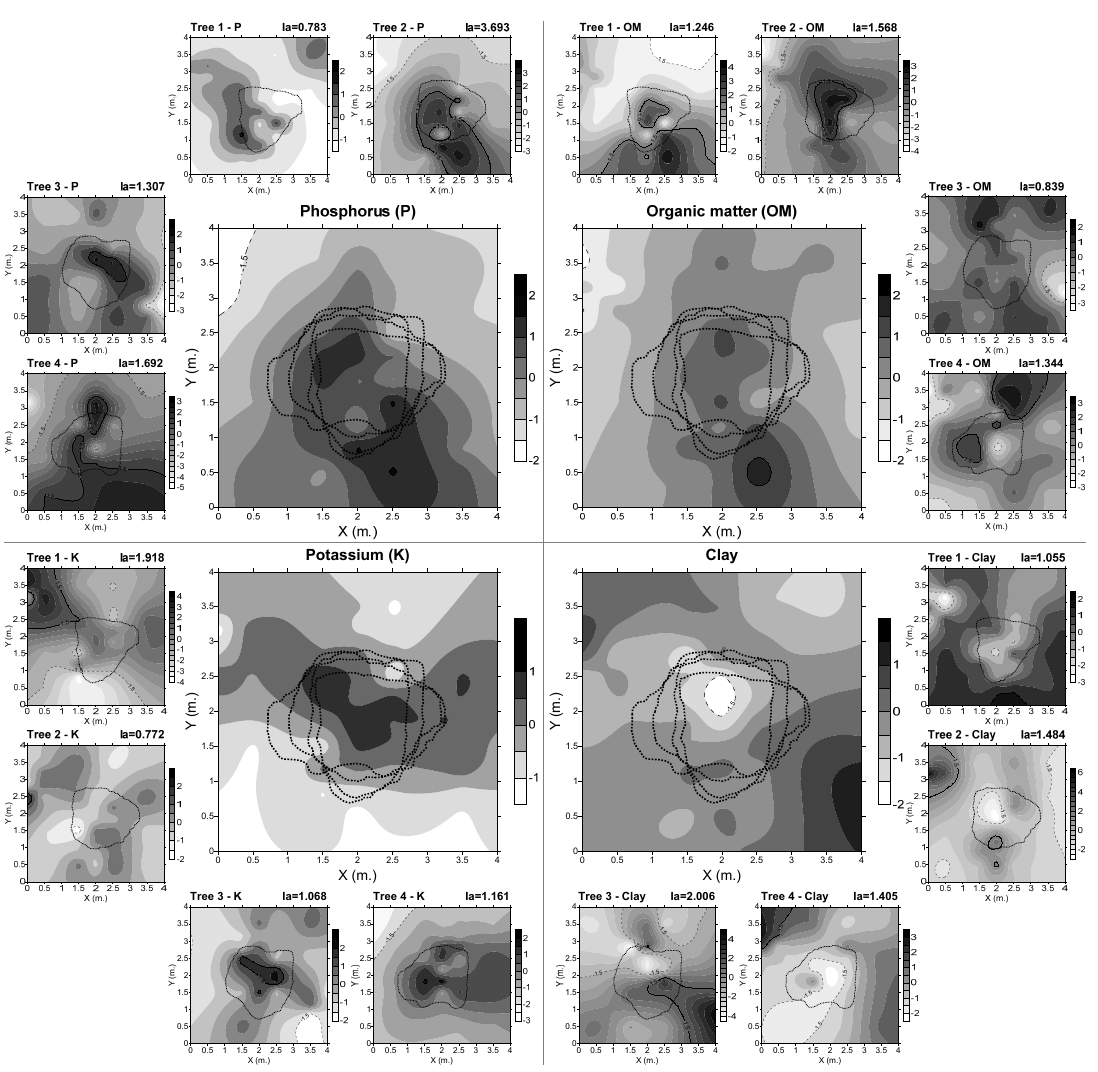
Figure 4. Maps of clustering indices ( ν ) of the edaphic variables whose aggregation index ( I a ) presents statistical significance in at least two trees (Figure 2) and significant differences in mean value between grids regarding crown cover (Table 2). By columns: P (phosphorus), OM (organic matter), silt and clay. By rows, trees 1 to 4 (projected to 4 × 4 m surface). The darker areas show clustering patches of edaphic variables ( ν > 1.5) are delimited by a continuous line, and the light areas show edaphic variables clustering gaps ( ν < − 1.5) are delimited by a discontinuous line. The dotted lines represent the crown cover of each tree. In the upper right corner of each sampling unit, the overall general aggregation pattern ( I a ) is indicated. Legend ( ν ) is unitless.